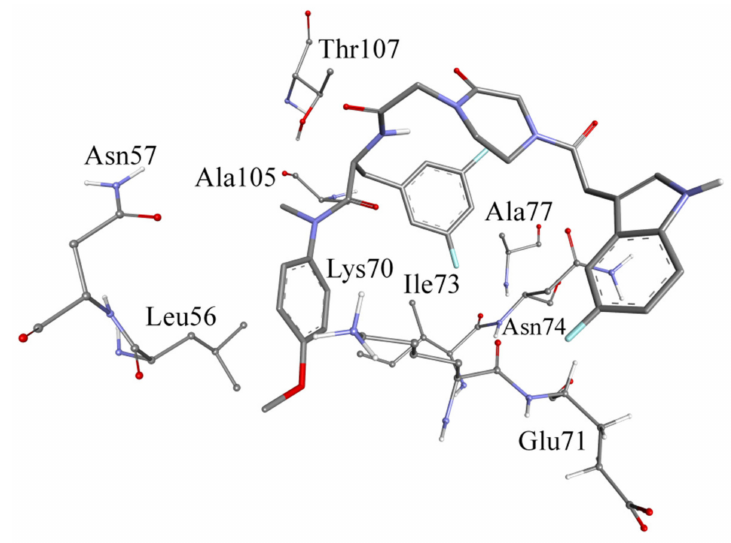
Figure 5. Binding of F 2 -7f to HIV-1 CA in the most populated